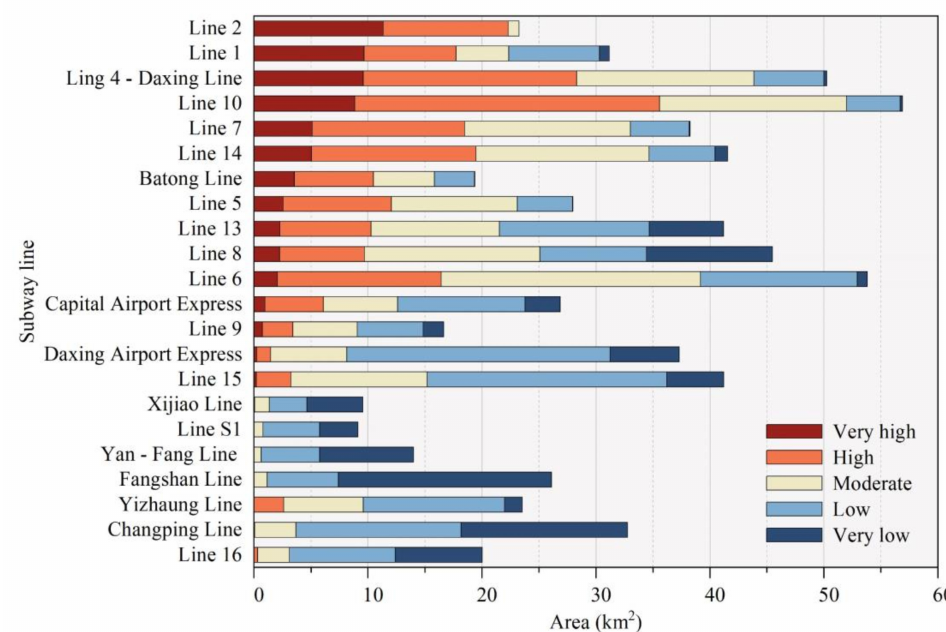
Figure 14. Area distribution at different risk levels for each subway